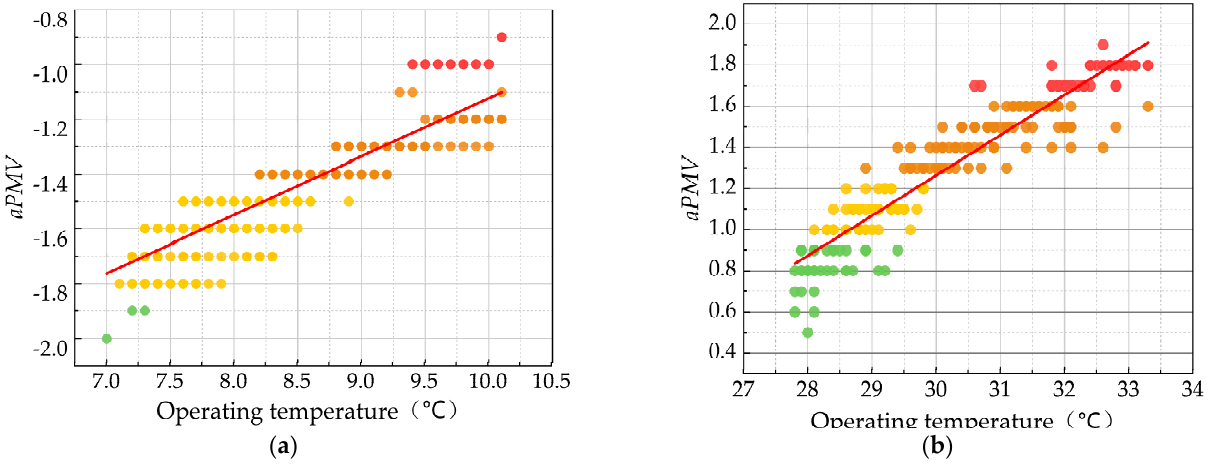
Figure 11. Operating temperature as a function of aPMV distribution. ( a ) Winter; ( b )